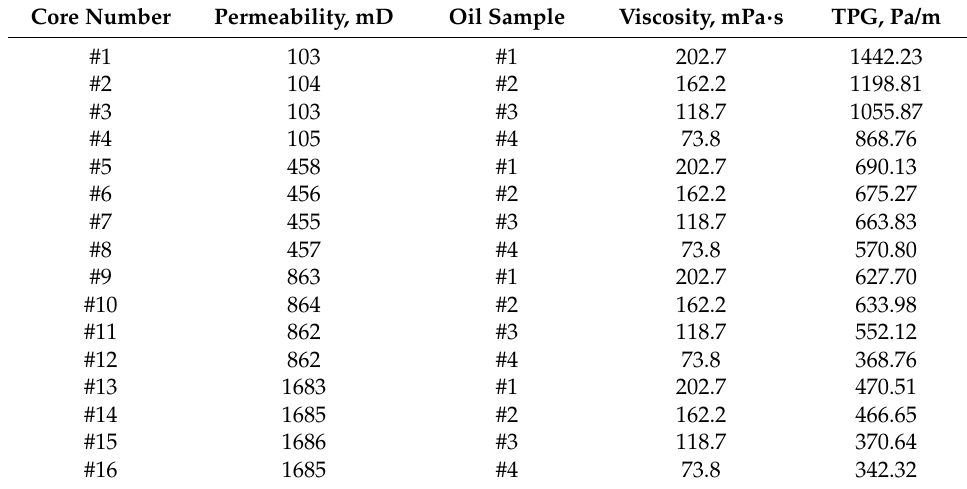
Table 6. The measured TPG of heavy oil.